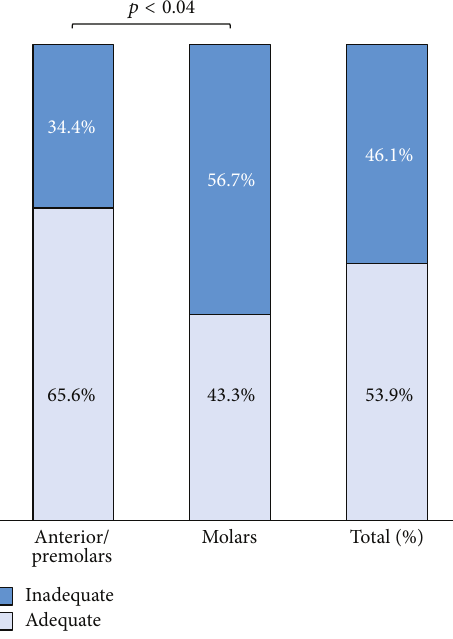
Figure 1: Overall quality (%) of root canals in maxillary and man- dibular